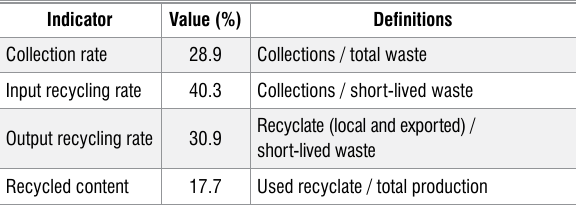
Mass-based indicators based on material flow analysis for 2018